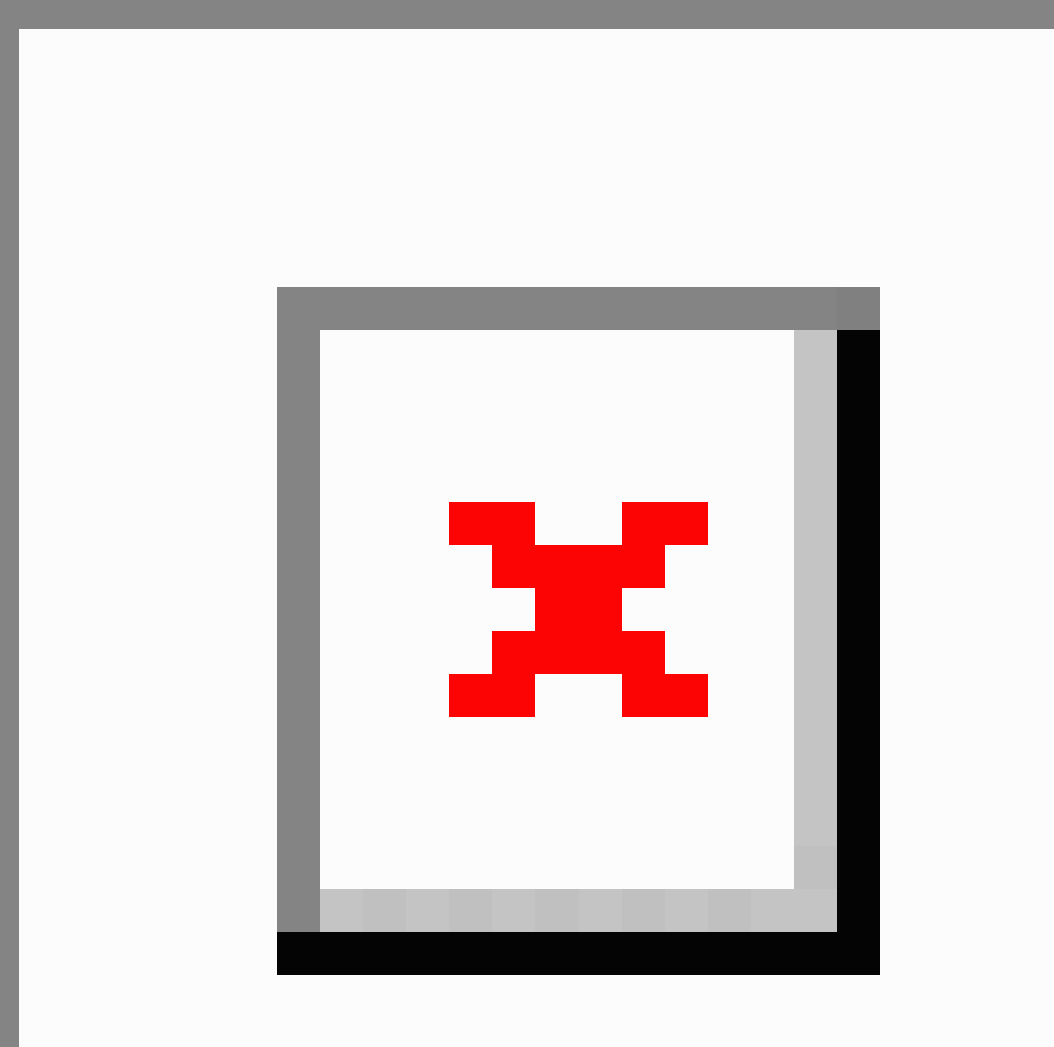
Figure 2. Total number of prenatal clinical visits per group. Babyscripts (Brx) versus controls. P value is based on Wilcoxon ranked-sum